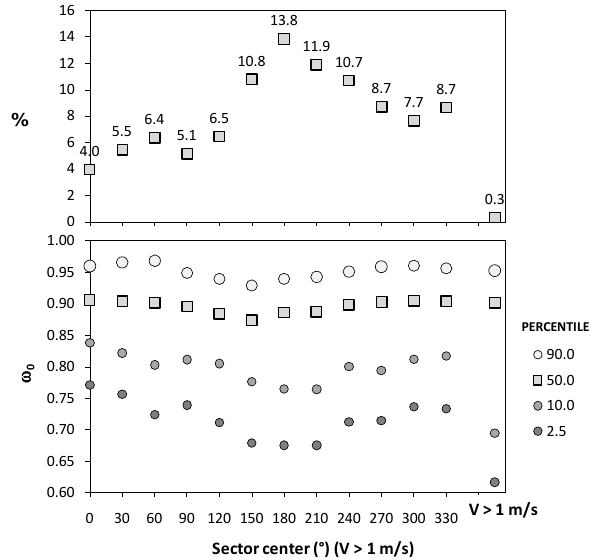
Fig. 17. Selected percentiles of cumulative distributions of ω 0 in 12 wind sectors and in the calm data ( v < 1ms − 1 ) (lower panel), and the contribution of data from these sectors (upper